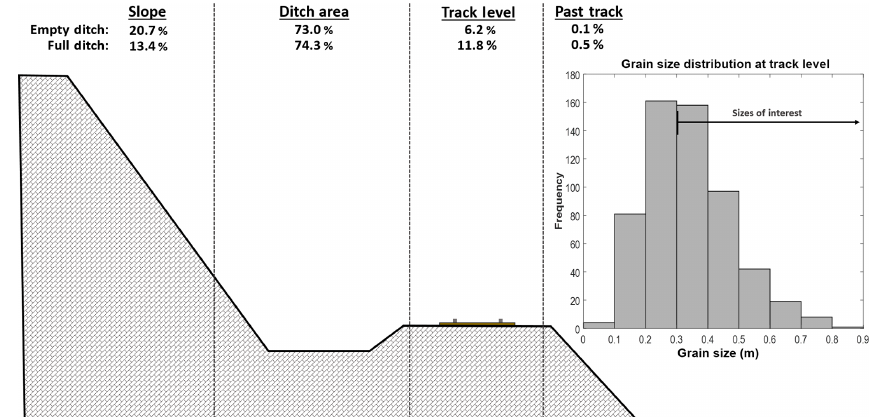
Figure 22. A schematic overview of the volume percentages stopping at different locations for the 15 simulation iterations using the empty and full ditch geometries. Simulation using the full ditch geometry resulted in nearly twice as much material reaching track level. The distribution of the grain sizes which reached track level in the full ditch scenario is also shown.